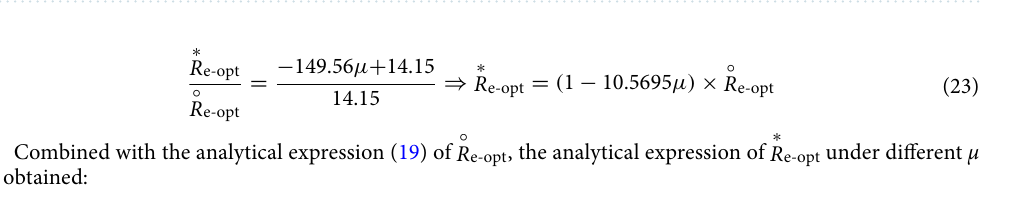
Figure 7. Linear fitting curve of R e-opt with respect to